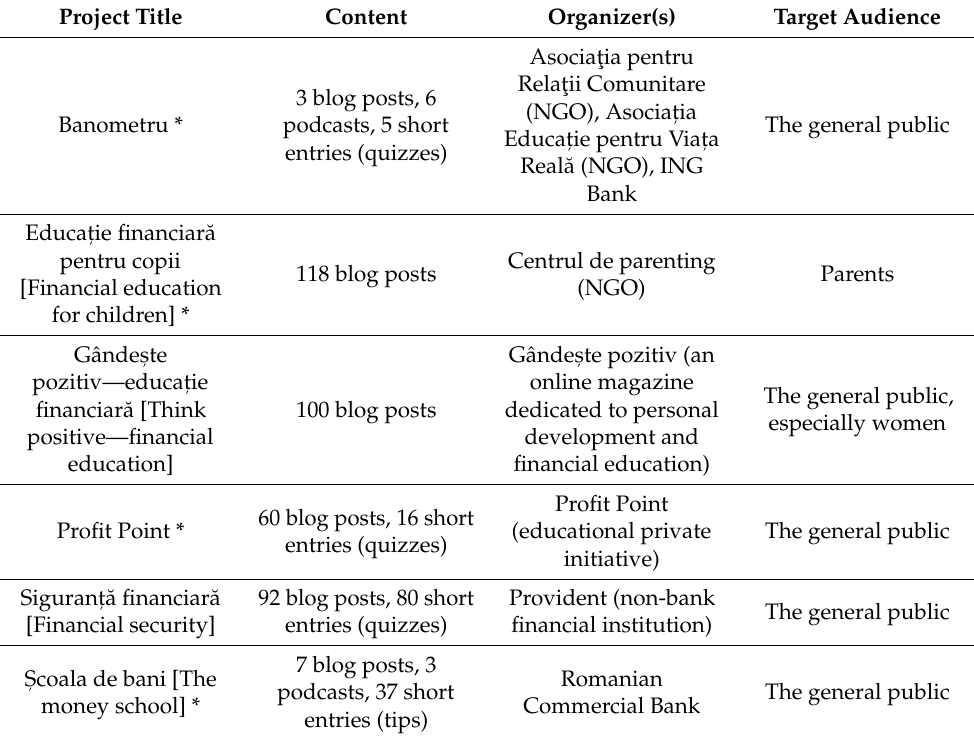
Table A1. Projects of Financial Education